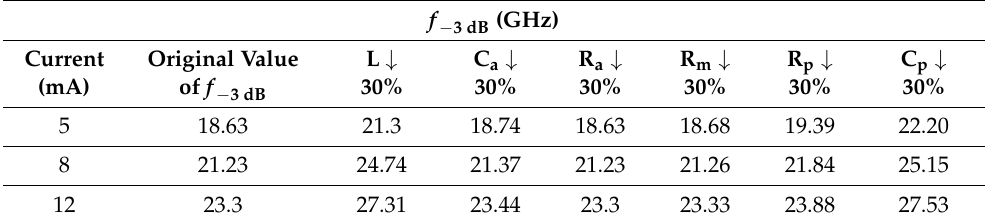
Table 1. Dependence of the parasitic − 3 dB frequency on 30% reductions of various circuit elements.